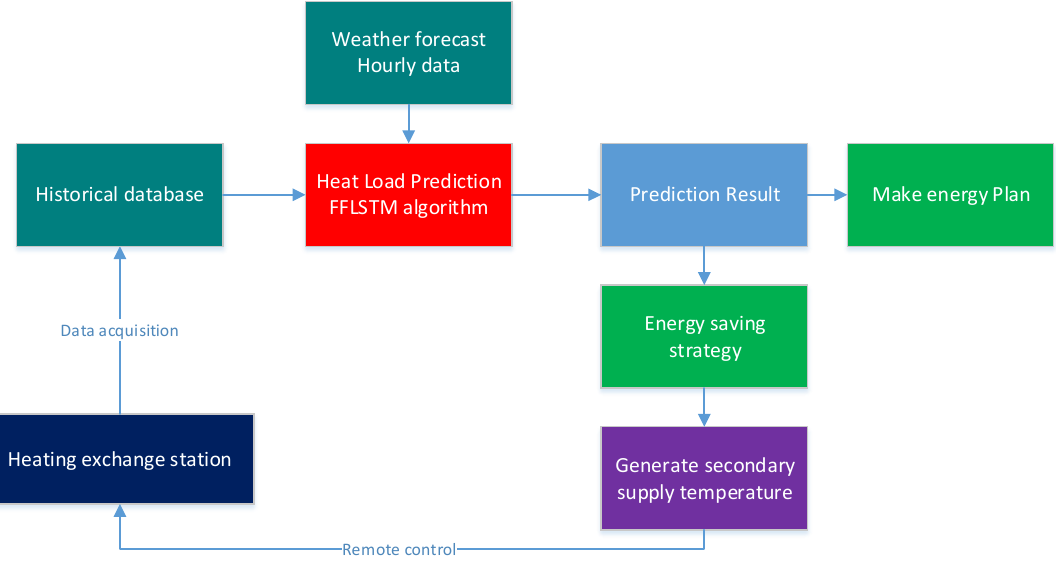
Figure 7. The operation process of the FFLSTM prediction algorithm in a smart district heating system